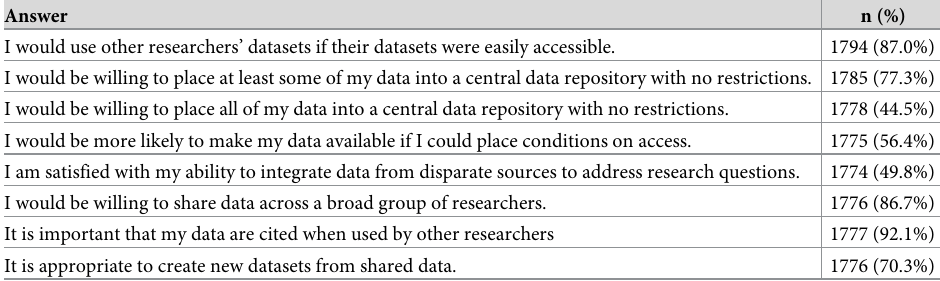
Table 7. “The following statements relate to sharing scientific data. Tell us how much you agree with each state- ment”. (Answers “Agree Somewhat” and “Agree Strongly” combined). Answer